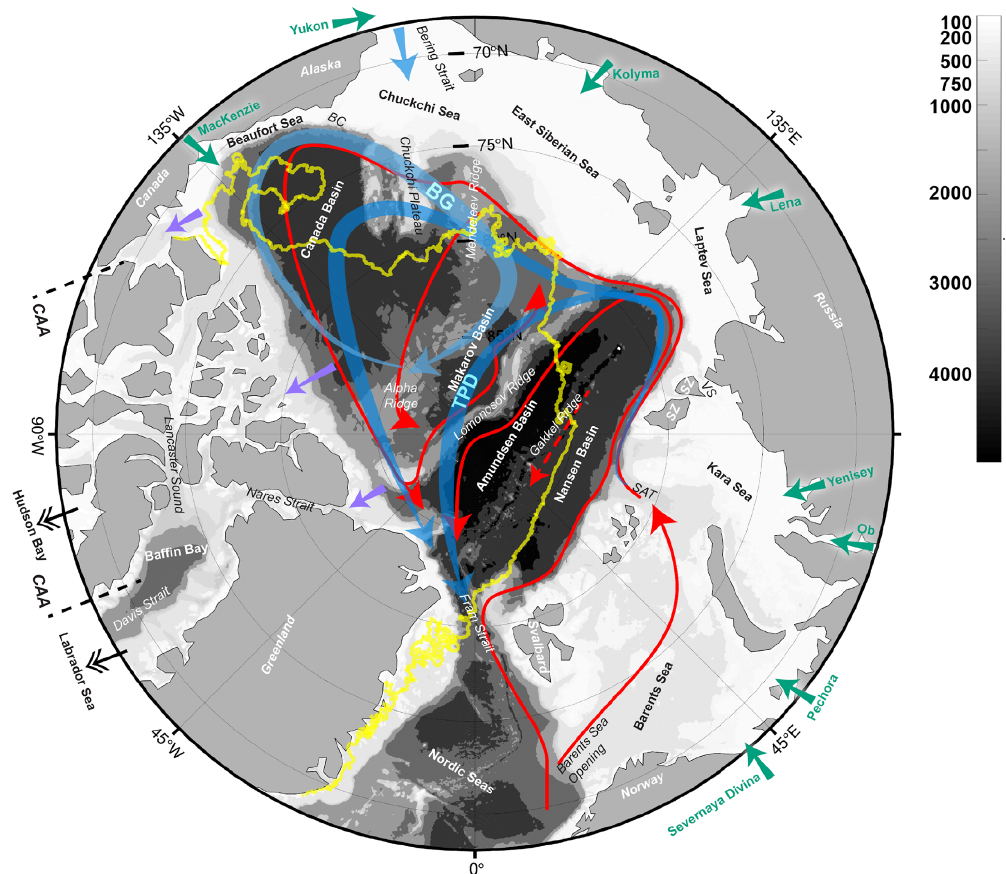
Figure 1. Map of the Arctic Ocean with names of major basins and shelf seas as well as ocean circulation features: major river and Pacific inflow (cyan and turquoise) and surface outflows (purple), 2020 minimum sea ice edge (yellow), cold and fresh upper ocean circulations (polar surface water and halocline; blues), and warm and salty Atlantic water circulation (red). Areas shallower than 1000m are referred to as shelf areas in the text. BG: Beaufort Gyre; TPD: transpolar drift; BC: Barrow Canyon; CAA: Canadian archipelago; SAT: St. Anna Trough; VS: Vilkitsky Strait; SZ: Severnaya